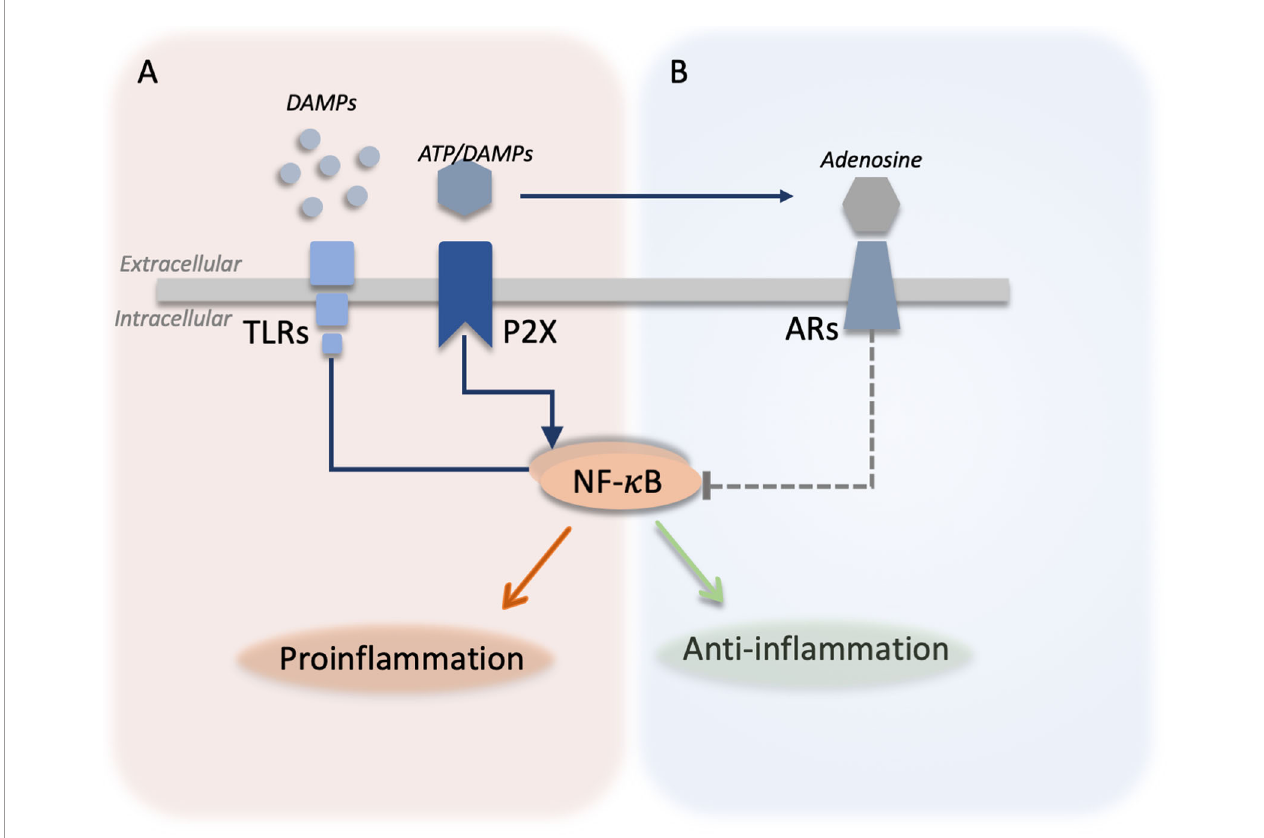
FIGURE 2 | Integration between DAMPs signaling and adenosine signaling. (A) Different danger-associated molecular patterns (DAMPs) molecules are released by the cells and can be sensed by toll-like receptors (TLRs) leading to the activation of nuclear factor kappa B (NF- k B) and the production of proin fl ammatory cytokines. Similarly, adenosine triphosphate (ATP) is actively or passively released from damaged cells and activates purinergic ATP receptors (P2X) activating proin fl ammatory responses in the cells. ATP can be broken down by ectonucleotidases producing adenosine. (B) Adenosine activates adenosine receptors (ARs) and inhibits (dotted green line) TLR and P2X signaling by downregulating the NF- k B-mediated production of proin fl ammatory